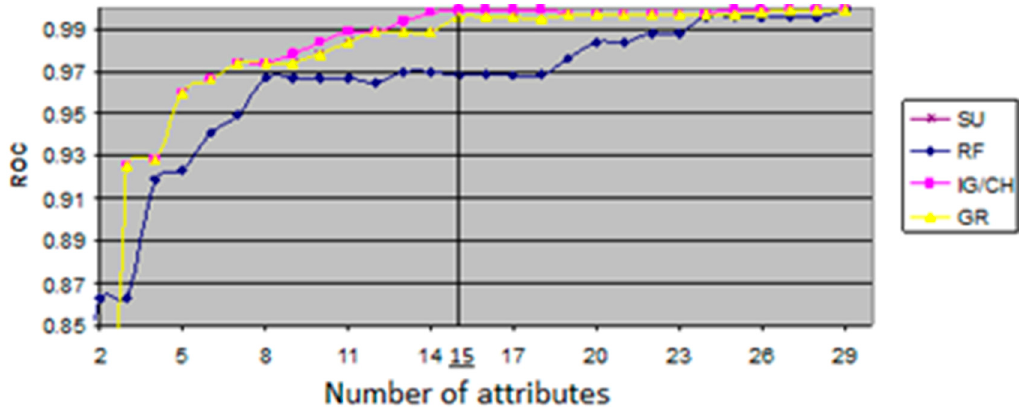
Figure 2. ROC value as a function of attribute number.